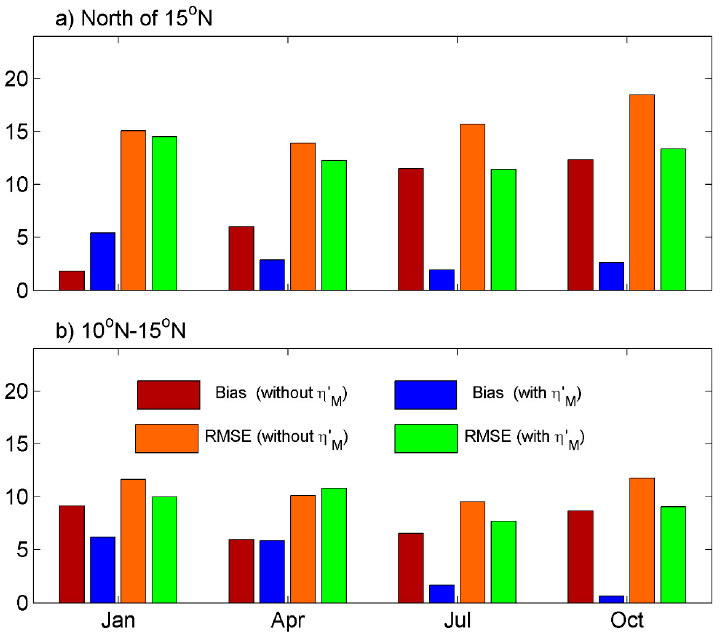
Figure 8. Bias and RMSE (Unit: m) between the altimeter-derived and Argo-data-derived ULT for the South China Sea ( a ) north of 15°N and ( b ) between 10°N and 15°N.